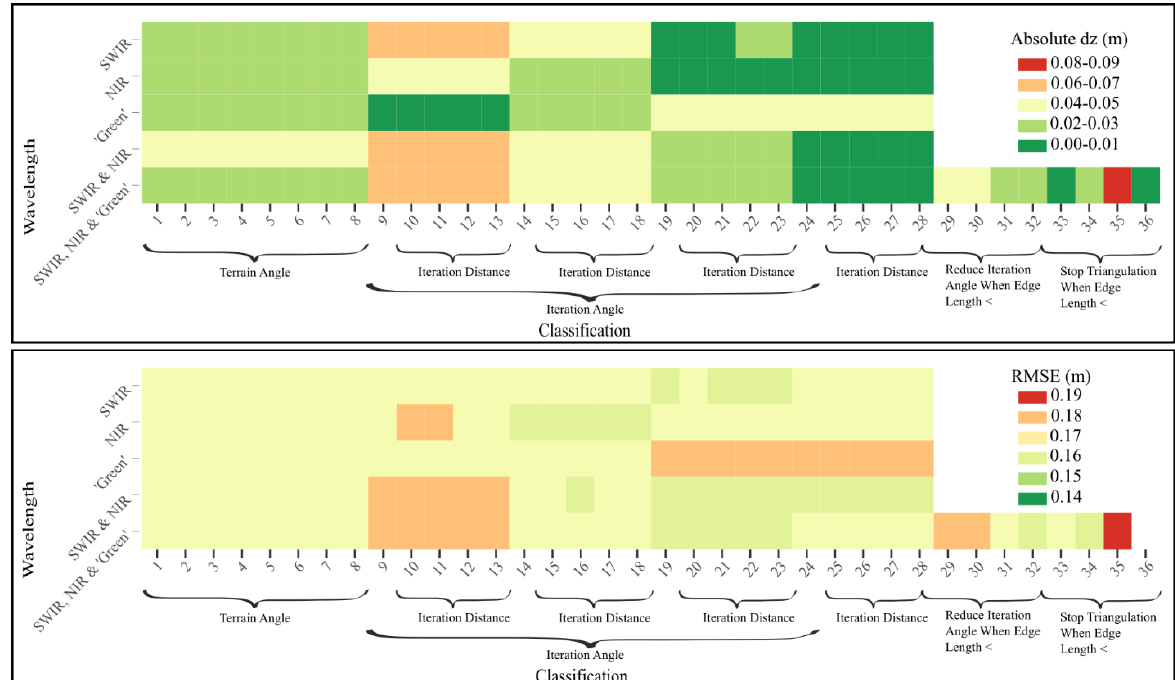
Figure 8 . Ground classification results (| 𝑑𝑧̅̅̅ | and RMSE) in burned peatlands unsegregated based on vegetation regeneration two years post-fire (true representation of two years post-fire). Classifications were conducted in TerraScan.